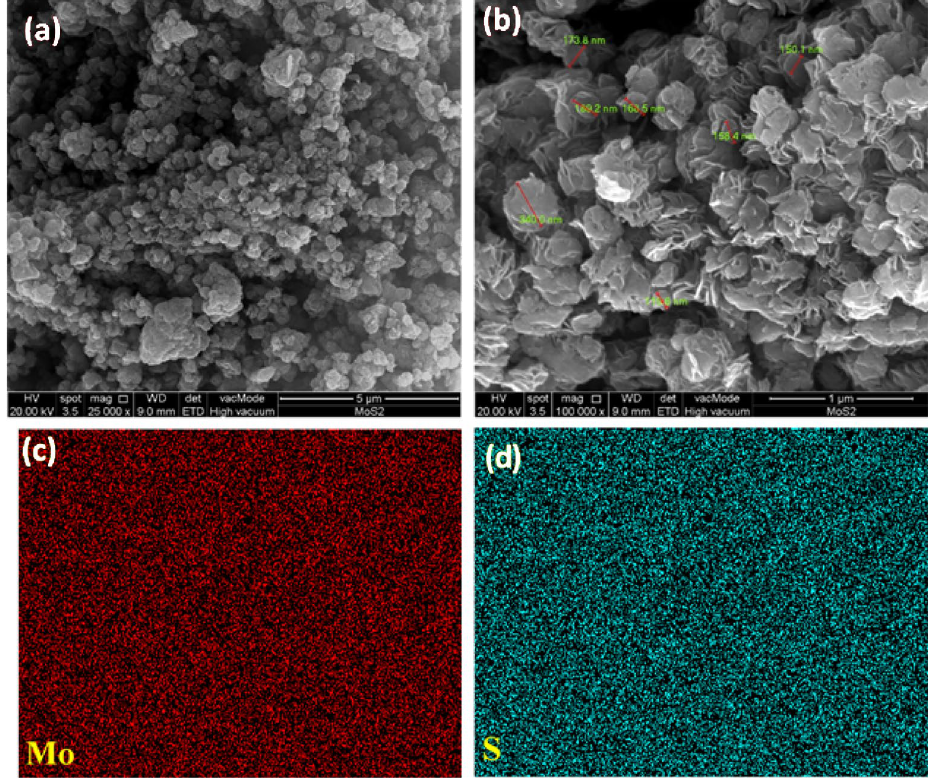
Figure 1. ( a , b ) Field Emission Scanning Electron Microscope (FESEM) ( c , d ) Energy Dispersive X-Ray Spectroscopy (EDS) mapping of the synthesised MoS 2